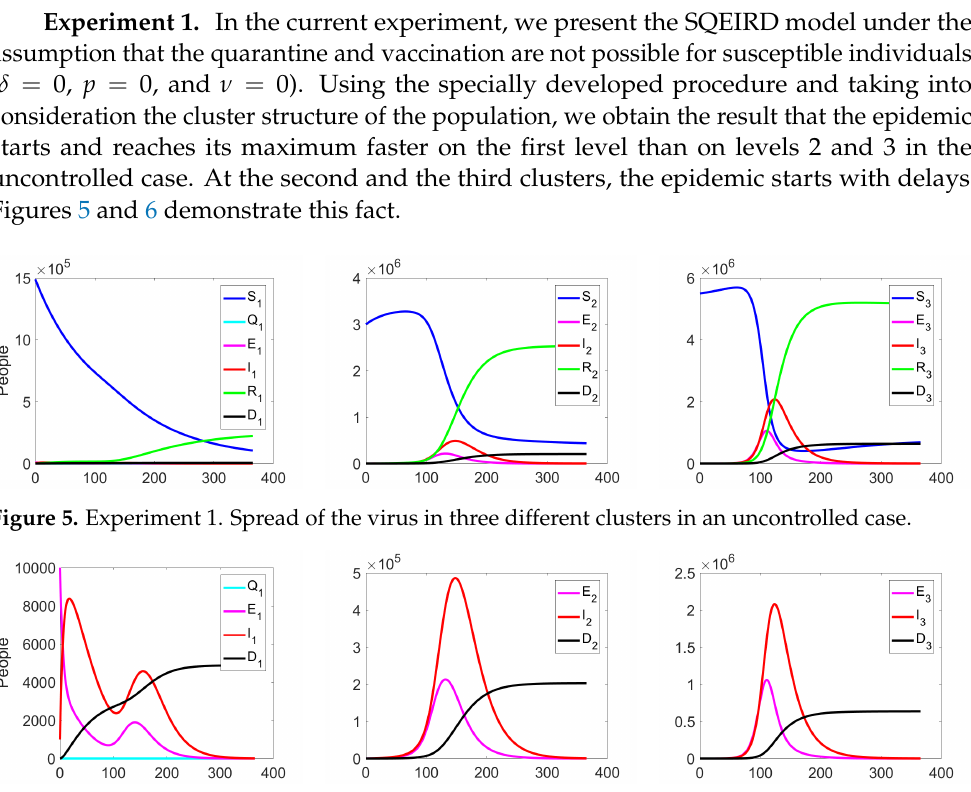
Figure 6. Experiment 1. Number of Exposed, Infected, and Dead in uncontrolled case.